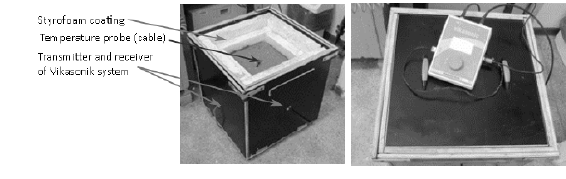
Figure 1: Methods of testing development of concrete hardening temperature and setting